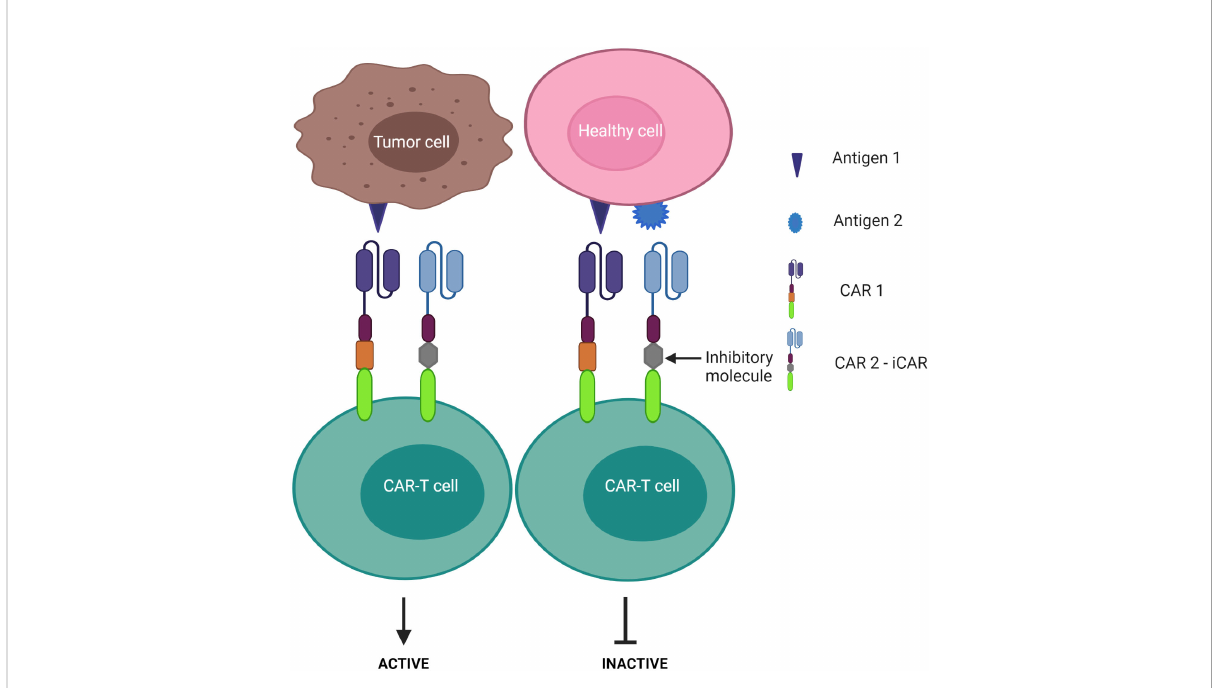
FIGURE 8 “ NOT ” logic-gated CAR-T cells selectively kill tumor cells expressing only tumor antigen 1 while the second CAR functions as an iCAR to inhibit CAR-T killing activity against antigen 1-positive normal